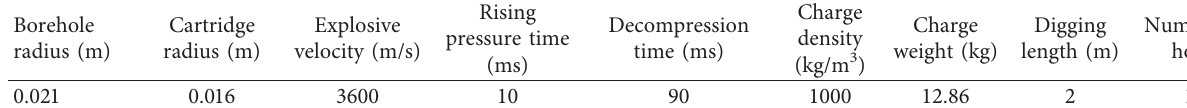
Table 3: Loading parameter of the test.